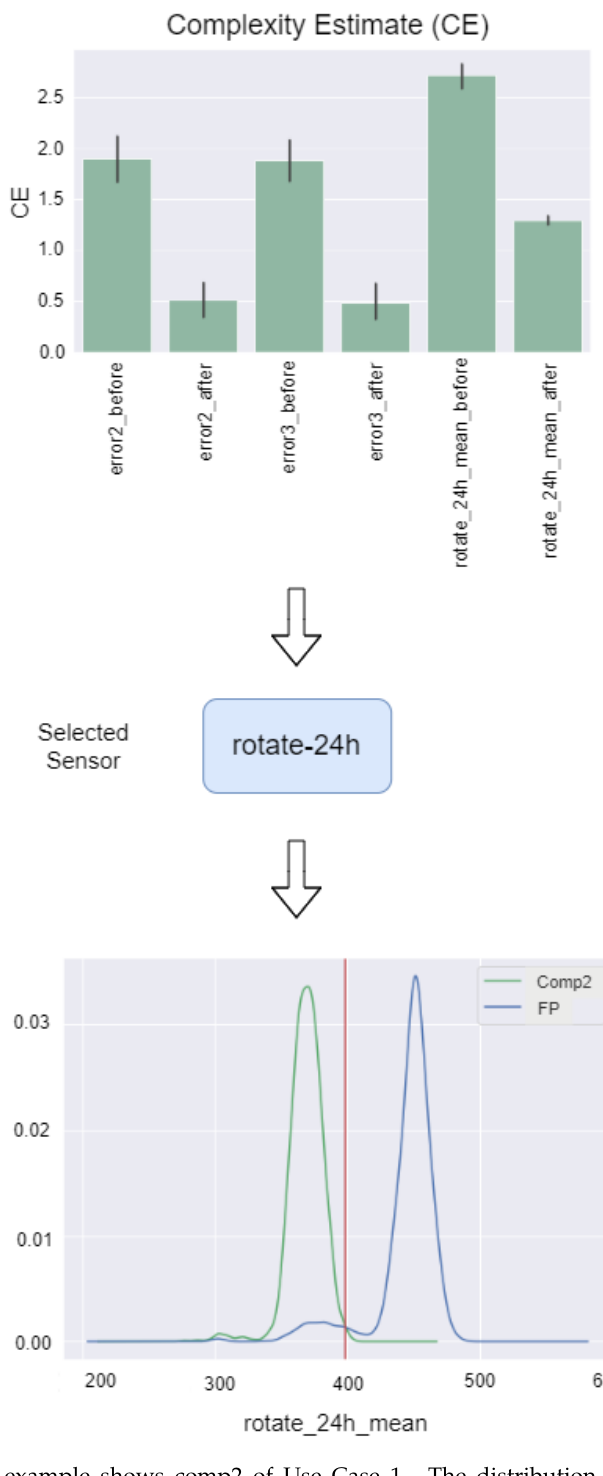
Figure 3. This example shows comp2 of Use Case 1. The distribution analysis is split into three consecutive steps of analysis of the feature ratio before and after the known maintenance events based on ce _ ratio and ci _ ratio , selection of the most informative feature, and definition of distribution